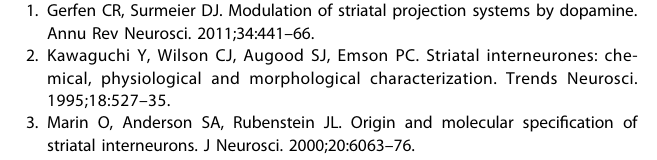
Drd2 Forward: CGGGAGCTGGAAGCCTCGA Drd2 Reverse: TGCAGGGTCAAGAGAAGGCCG Adora2a Forward: ATGGGCTCCTCGGTGTACATCATG Adora2a Reverse: TCAGGAAGGGGCAAACTCTGAAGAC Drd1 Forward: ATGGCTCCTAACACTTCTACCATGG Drd1 Reverse: TCAGGTTGAATGCTGTCCGCTGTG Tac1 Forward: CCCCTGAACGCACTATCTATTC Tac1 Reverse: TAGAGTCAAATACCGAAGTCTCAG Isl1 Forward: TACGGGATCAAATGCGCCAA Isl1 Reverse: ACTCAGTACTTTCCAGGGCG Ppp1r1b Forward: CCAGACACCCCAAGAACG Ppp1r1b Reverse: